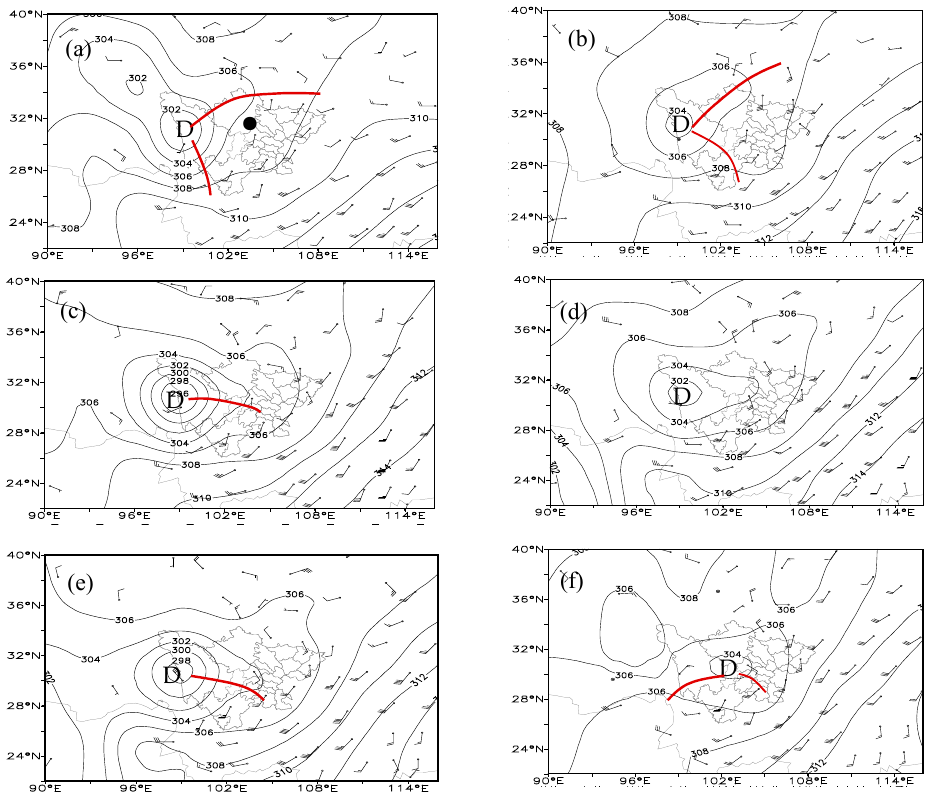
Figure 5. The 700-hPa geopotential height field (gpdam) and wind field (m/s) at ( a ) 1200 UTC 7 July, ( b ) 0000 UTC 8 July, ( c ) 1200 UTC 8 July, ( d ) 0000 UTC 9 July, ( e ) 1200 UTC 9 July, and ( f ) 0000 UTC 10 July. D: the cyclonic vortex, the thick brown line: shear line.